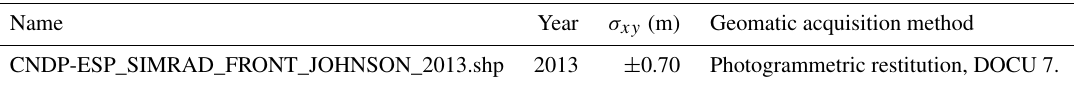
Table 7. ARCGIS shape file corresponding to the photogrammetric restitution of the Johnsons Glacier calving front in February 2013. The photo was obtained with a non-metric camera. In the third column the RMS error is shown.